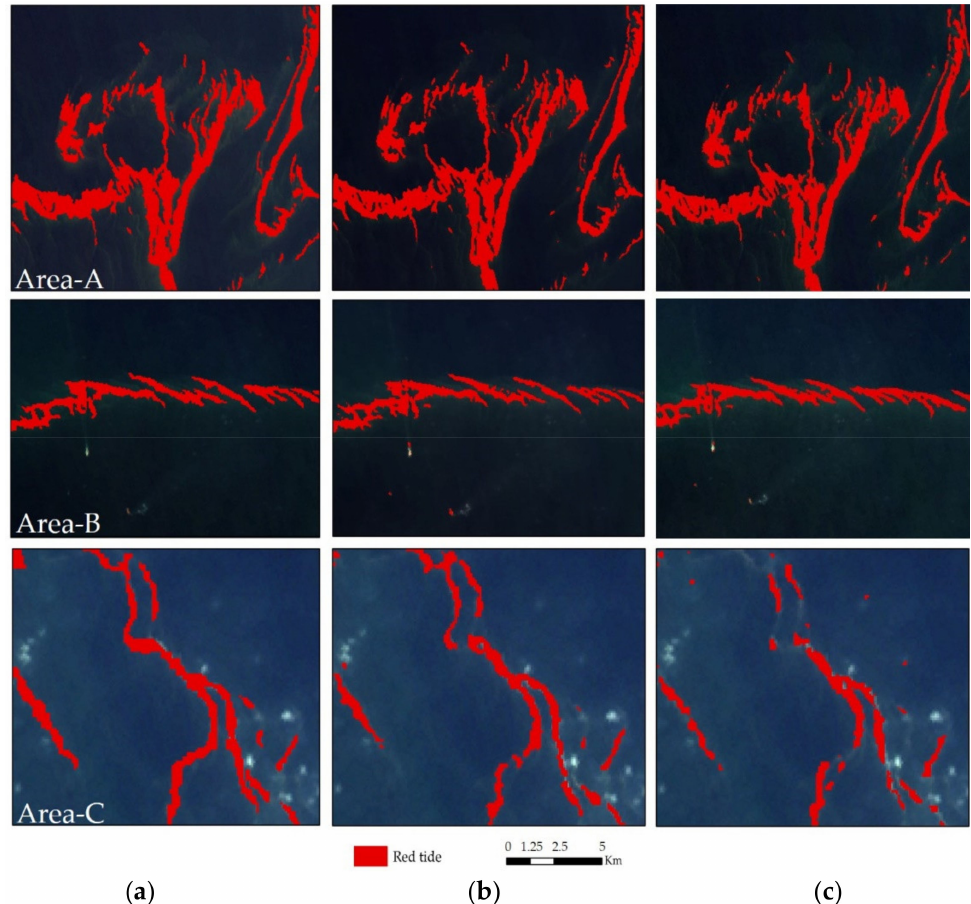
Figure 10. Local view of red tide detection results based on different datasets. ( a ) Validation map; ( b ) Red tide detection result for the multi − feature dataset; ( c ) Red tide detection result for the four − bands dataset. The red regions represent red tides.